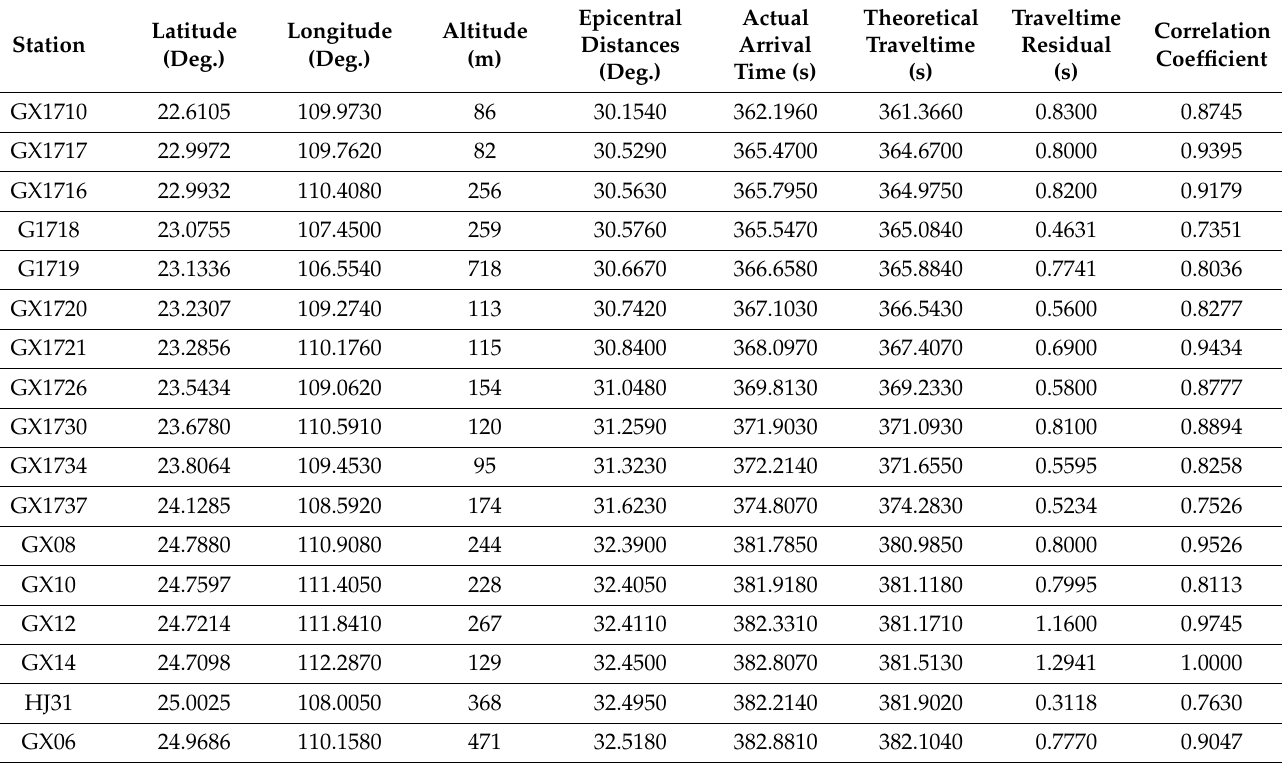
Table 2. P-wave traveltime data table for the 6.5 magnitude earthquake in Java, Indonesia on